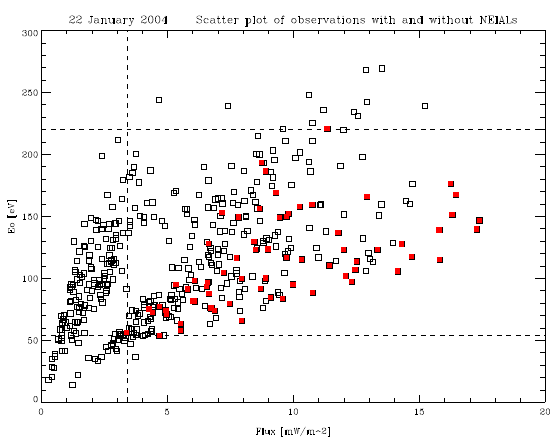
Fig. 5. The energy flux versus the characteristic energy. The red squares represent NEIALs events. Two populations can be seen. They mostly coincide with the time before and after 09:00